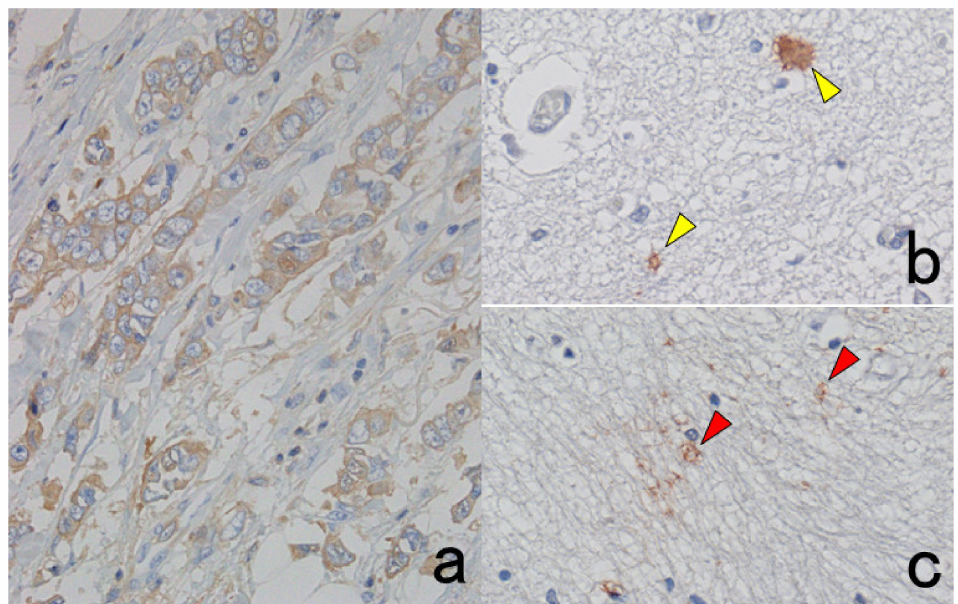
Figure 65. Immunostaining with the serum of two patients with autoimmune encephalitis. ( a ): Para- neoplastic (breast cancer-associated) autoimmune encephalitis (Stiff-Man syndrome) with autoanti- bodies to amphiphysin, a 128-kDa presynaptic protein. ( b , c ): Autoimmune limbic encephalitis. The patient’s 1:20 diluted serum immunostains her own FFPE breast cancer cells ( a ). The 1:20 diluted serum of limbic encephalitis decorates astroglia (yellow arrowheads in panel ( b )) and their glial processes (red arrowheads in panel ( c )) in normal basal ganglia embedded in paraffin from another autopsy